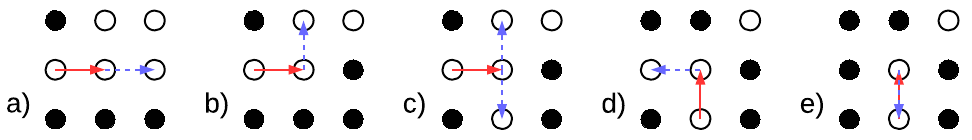
Figure 5. Movement possibilities in the PSA algorithm: ( a ) forward movement, ( b ) one side movement, ( c ) random sideways movement, ( d ) backward movement, ( e ) no possibility of